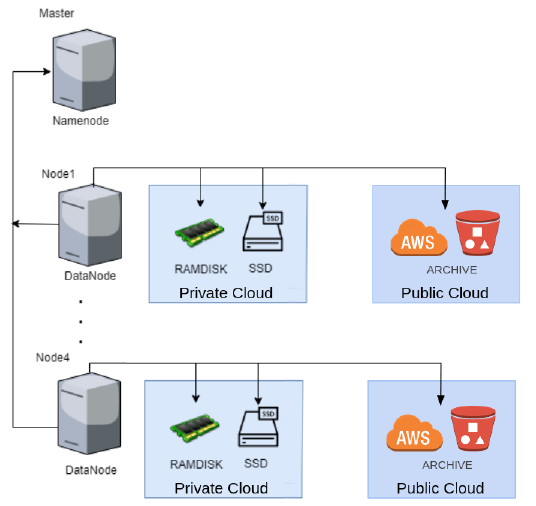
Figure 3. Hadoop cluster architecture and public